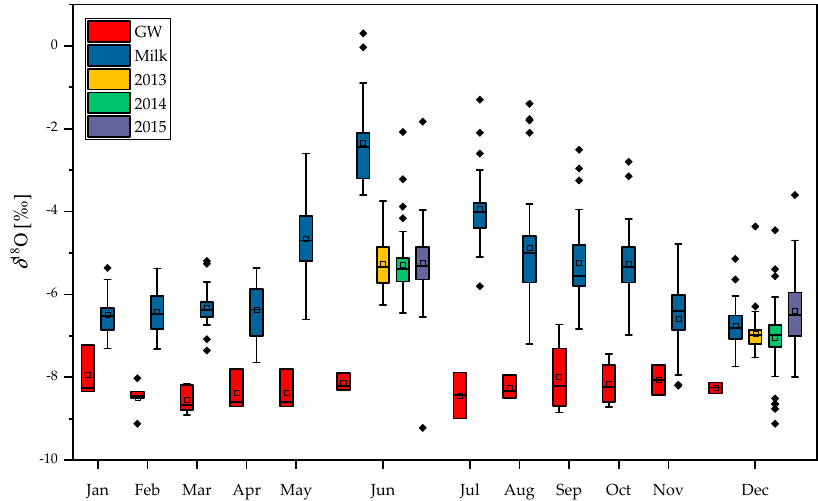
Figure 5. Seasonal variability in δ 18 O milk and δ 18 O GW values in 2012. For comparison, the box plot of δ 18 O milk values determined in June and December relative to the year (2013–2015) are presented on the graph. Data presented are taken for all regions in Slovenia.